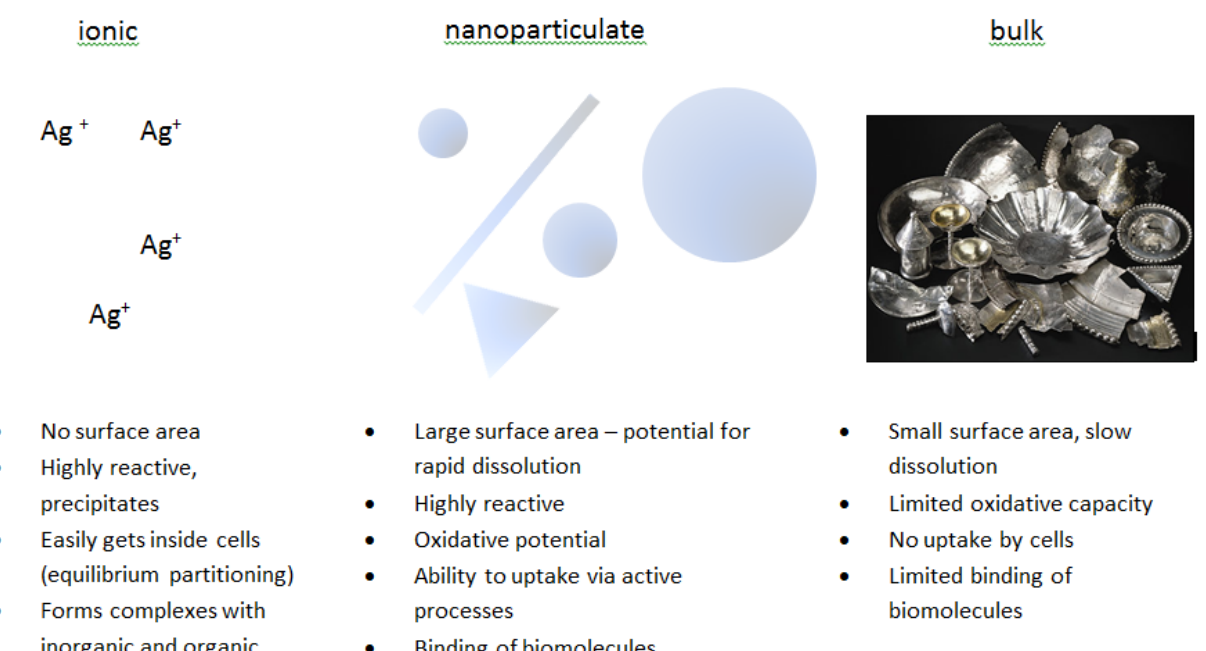
Figure 4. Main differences between ionic, nanoparticulate and bulk